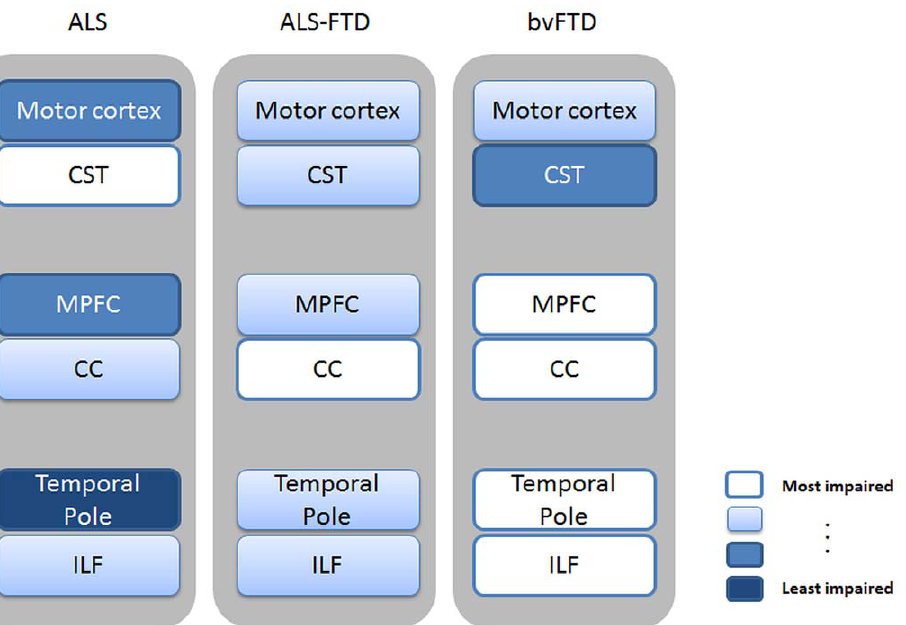
Figure 5. Schematic summary of main findings. Summary of main grey matter regions and their underlying white matter tracts across patient groups. Shading of text boxes indicates severity of impairment based on the imaging findings with lighter boxes indicating higher impairment and darker boxes indicated lesser impairment. CST=corticospinal tract; MPFC=medial prefrontal cortex; CC=corpus callosum; ILF=inferior longitudinal